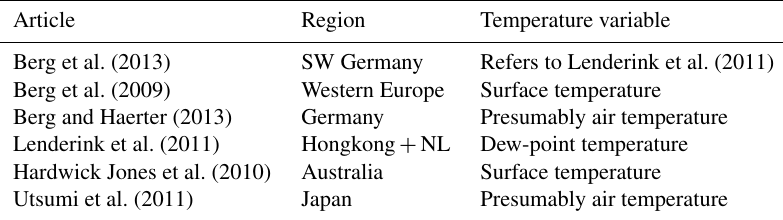
Table 2. Regions and temperatures used in the literature cited in Fig